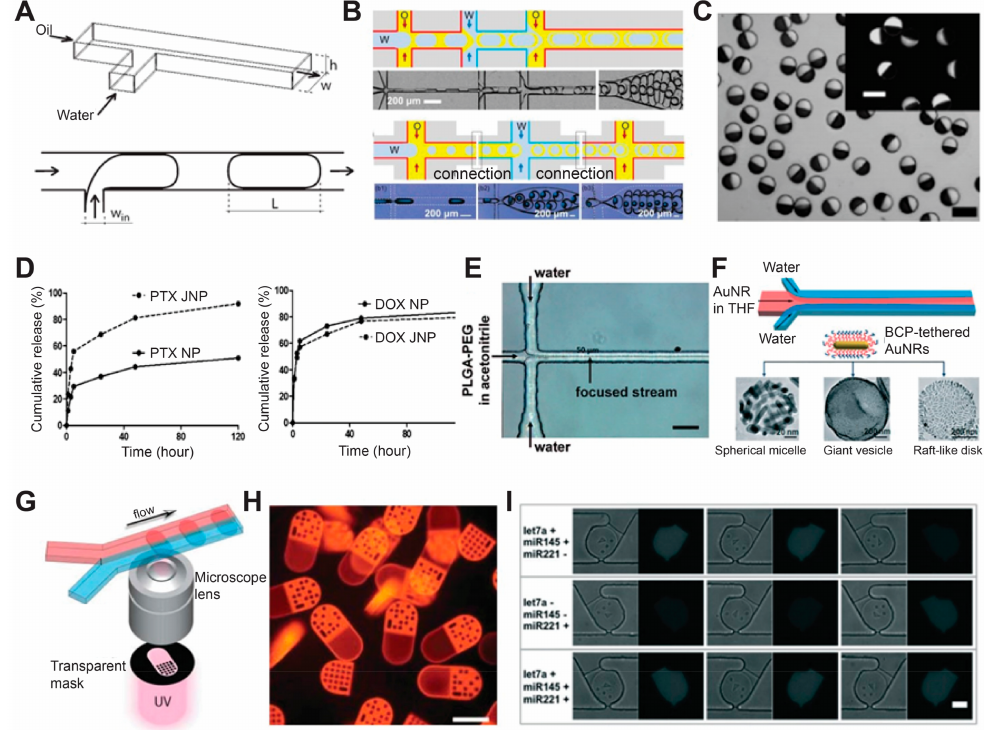
Figure 7. Microfluidic fabrication of nano/microparticles and their applications in drug delivery and disease diagnosis. ( A ) Single emulsion ( B ) multiple emulsion methods of droplet production in microfluidic channels [141], with copyright permission from © Royal Society of Chemistry; ( C ) Optical microscopy image of Janus particles (inset shows fluorescence image) [144], with copyright permission from © American Chemical Society; ( D ) Cumulative release of paclitaxel (left) and doxorubicin from Janus particle for co-delivery of two drugs [145], with copyright permission from © American Chemical Society; ( E ) A 2-dimensional HFF microfluidic device for generation of PLGA-PEG nanoparticles [147], with copyright permission from © American Chemical Society; ( F ) Hydrodynamic self-assembly of amphiphilic nanoparticles tethered with block copolymers [147], with copyright permission from © John Wiley and Sons; ( G ) Scheme of barcoded particle synthesis using flow lithography [145], with copyright permission from © The American Association for the Advancement of Science; ( H ) Fluorescence microscopy image of barcoded particles for multiplex analysis [145], with copyright permission from © The American Association for the Advancement of Science; ( I ) Multiplexed miRNA assay for three different dysregulation patterns using barcoded microparticles produced from the method in ( G ) [146], with copyright permission from © Royal Society of Chemistry. Scale bar 100 µ m for ( C , H ), 50 µ m for ( E , I